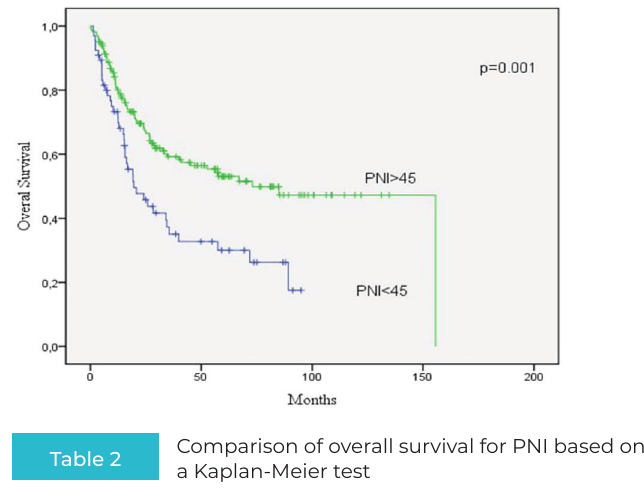
Figure 1 - Overall survival analysis by Kaplan-Meier test according to PNI